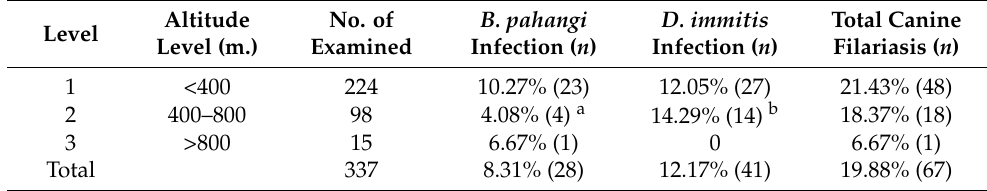
Table 3. The altitudinal distribution and prevalence of canine filariasis in Chiang Mai, Thailand.